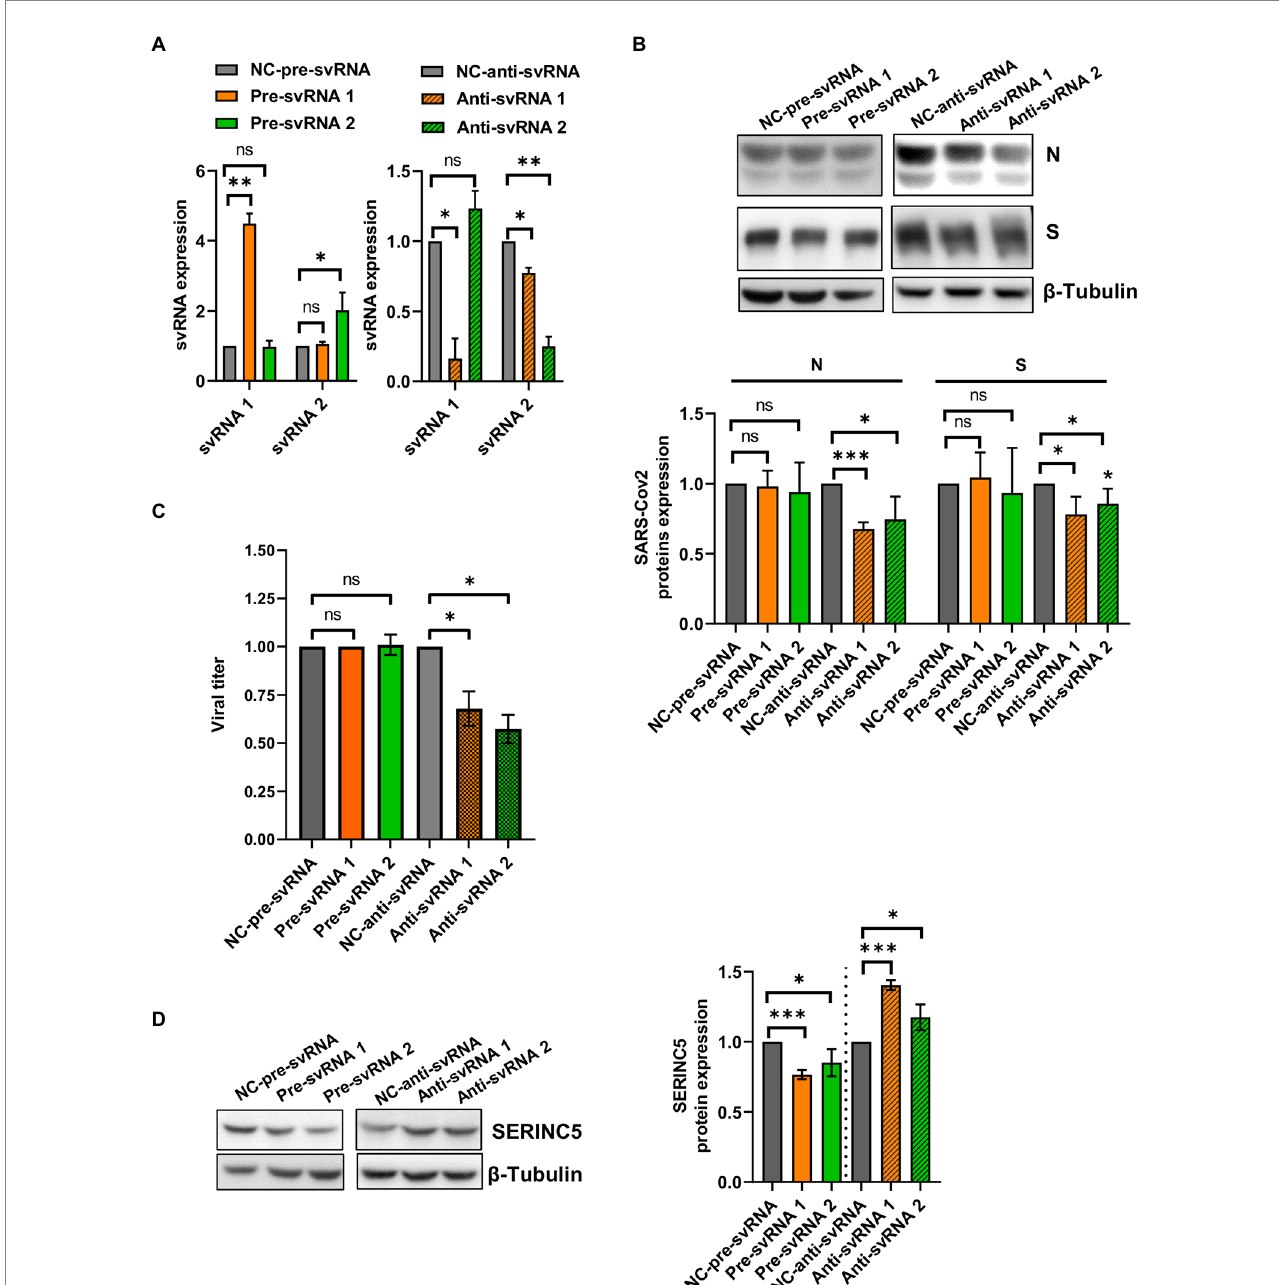
FIGURE 7 Expression levels of svRNAs 1 and 2, viral proteins and cellular SERINC5 in Vero E6 cells treated with mimic or anti-sense molecules for svRNA 1 and 2 and infected with SARS-CoV-2. Vero E6 cells were transfected with specific oligonucleotides mimic for svRNA 1 or svRNA 2 (Pre-svRNA 1 and 2), or specific antisense oligonucleotides for svRNA 1 or svRNA 2 (Anti-svRNA 1 and 2), and at 36 h post-transfection the cells were infected with SARS-CoV-2 (1 PFU/cell). The levels of svRNAs, N, S and SERINC5 proteins were analyzed at 20 hpi and the virus production in the cell supernatants at 24 hpi. (A) RT-qPCR analysis of svRNAs 1 and 2 levels in cells transfected with Pre-svRNA 1 and 2 (left panel), or Anti-svRNA 1 and 2 (right panel). Data are represented as fold change respect to the negative control (NC-pre-svRNA or NC-anti-svRNA)-transfected and SARS-CoV-2-infected cells (control samples). The control value represents the mean of all control samples. (B) Western blot analysis of viral N and S proteins. The scatter plot shows the densitometric analysis of N and S proteins normalized to β -tubulin and represented as fold change relative to negative control-transfected cells. The control value represents the mean of all control samples. (C) Virus production. The viral titers in the cell supernatants were determined at 24 hpi by plaque assay. Data are represented as fold change respect to the negative control (NC-pre-svRNA or NC-anti-svRNA)-transfected and SARS-CoV-2-infected cells (control samples). (D) Western blot analysis of SERINC5. The scatter plot shows the densitometric analysis of SERINC5 protein normalized to β -tubulin and represented as fold change relative to SARS-CoV-2-infected, negative control-transfected cells. The control value represents the mean of all control samples. Differences from negative control values were found to be statistically significant at * p < 0.05, ** p < 0.01 and *** p <